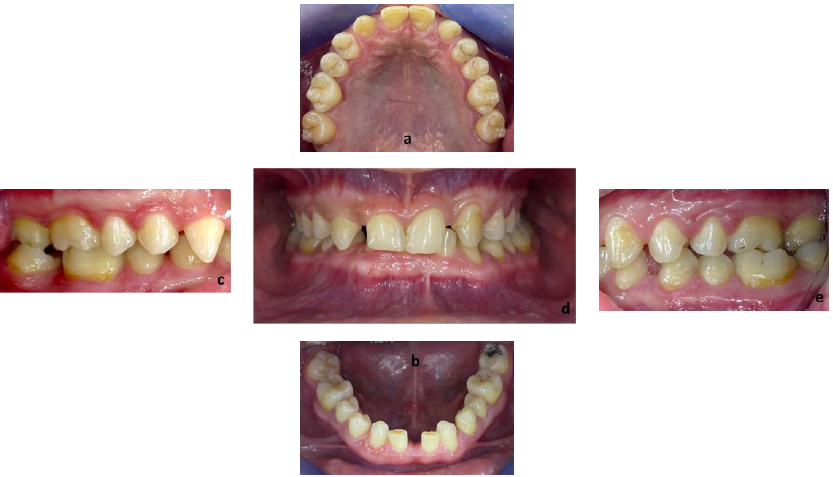
Figure 2. Endobuccal views: ( a ) maxillary arch, ( b ) mandibular arch, ( c ) right side occlusion, ( d ) front bite, ( e ) left side occlusion.